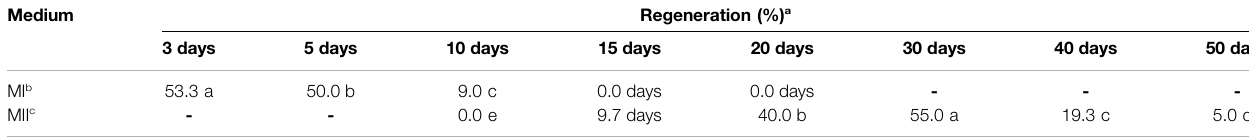
TABLE 7 | Effect of culture duration in MI or MII medium on shoot regeneration of fi eld cress.